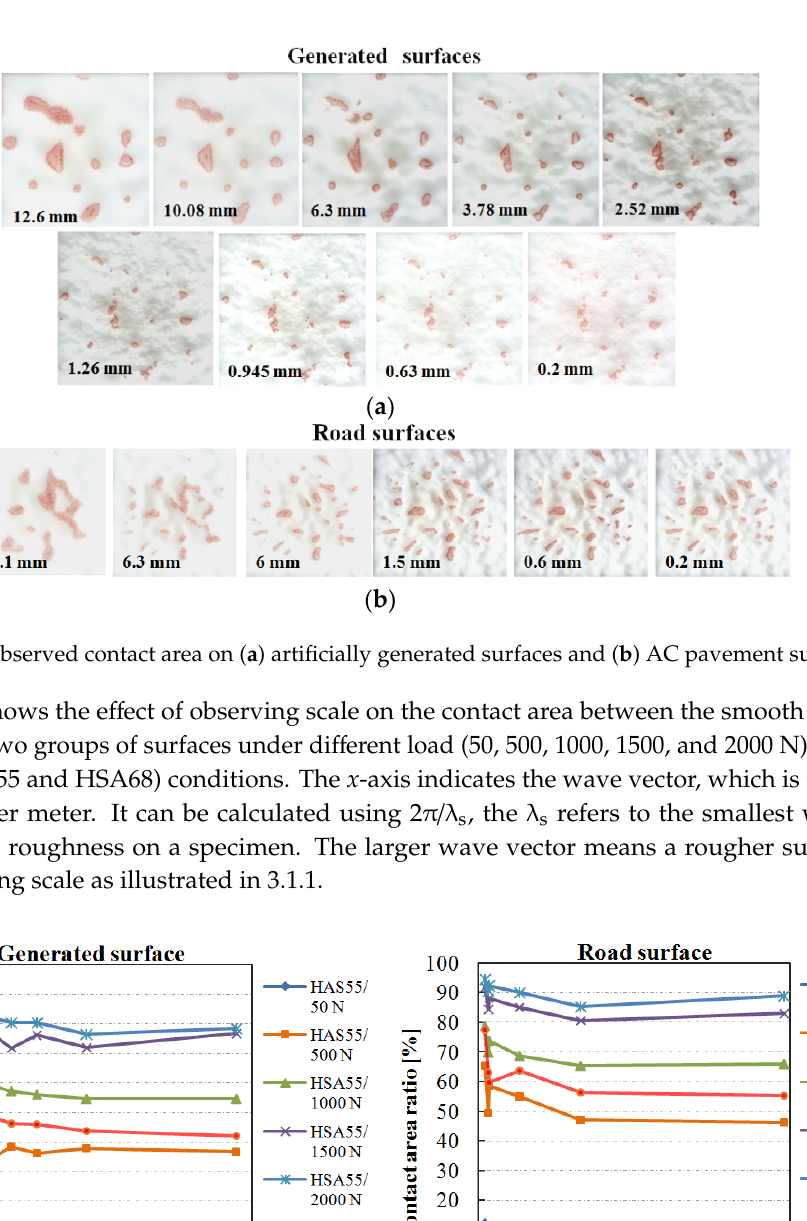
Figure 6. Effect of the observing scale on the contact area between a smooth rubber and ( a ) artificially generated surfaces; ( b ) road surfaces.